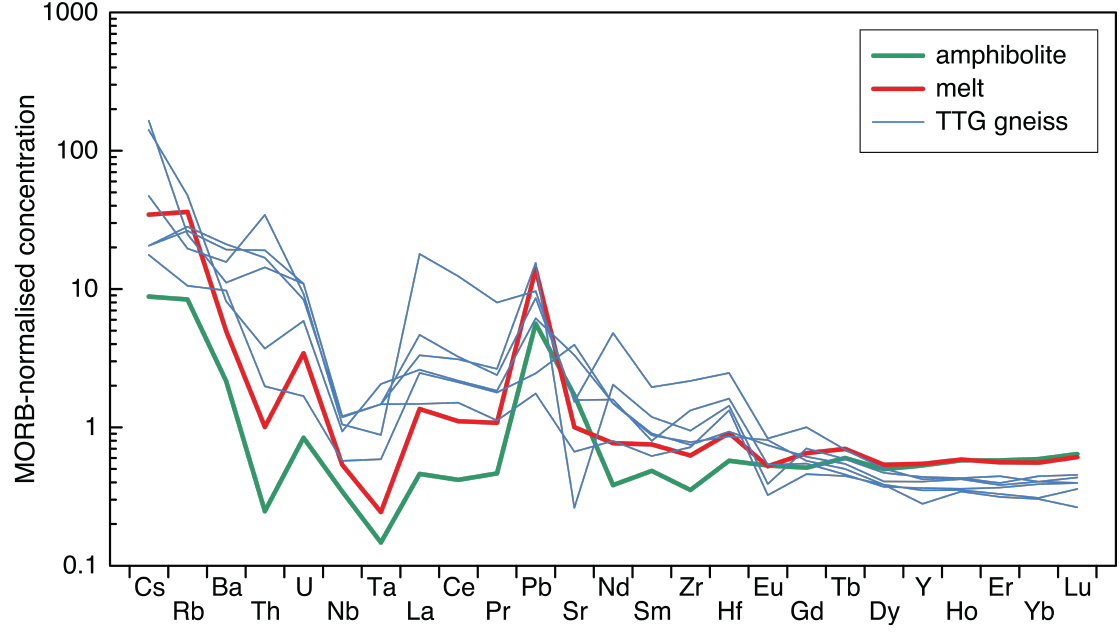
Figure 9. Comparison between the calculated trace element pattern of the partial melt (in red) and that of TTG gneisses that enclose the Tartoq greenstone belt (in blue). The composition of the parent amphibolite is also shown (sample 516509, in green). The trace element pattern of the partial melt is calculated from the pseudosection mineral and melt modes at 750 ◦ C and 8 kbar and the mineral-melt partition coefficients for tonalite from [34]. This calculation uses the solution models from